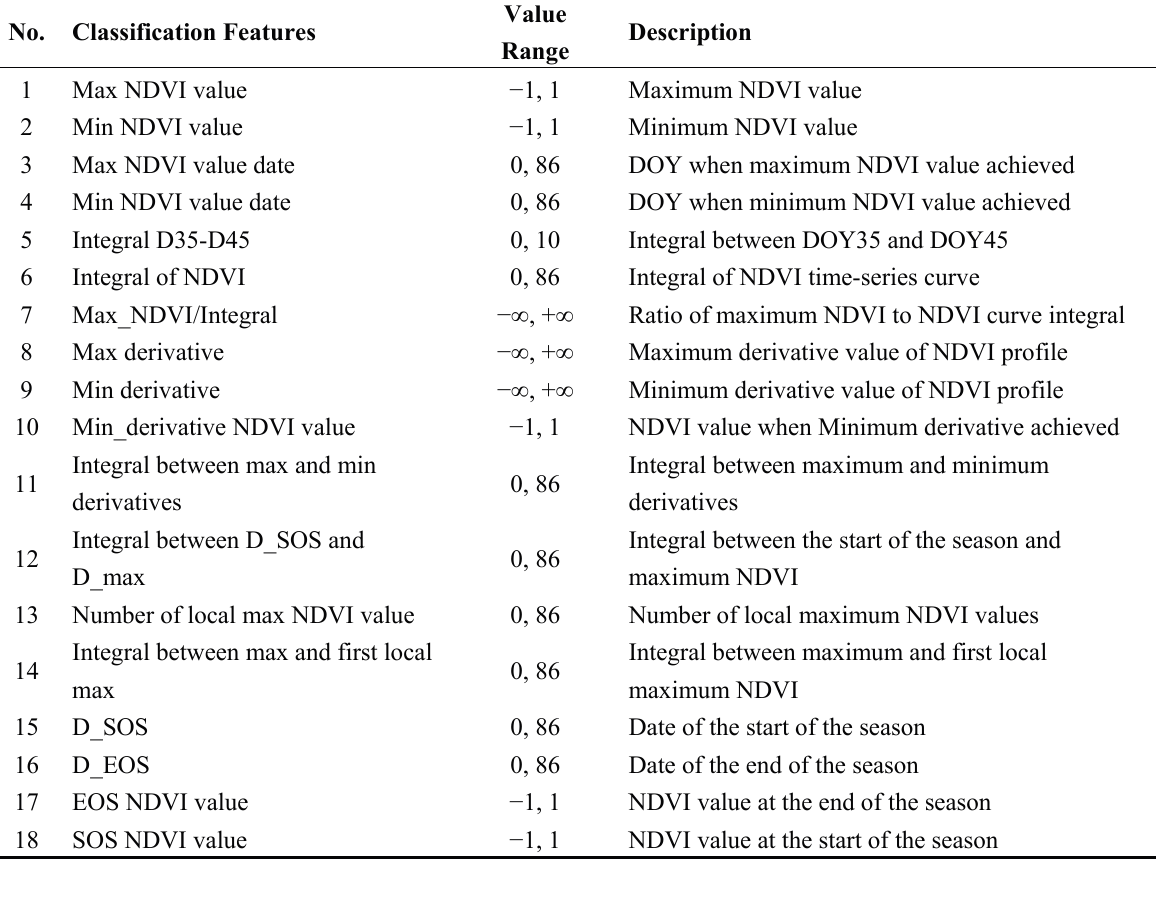
Table 2. The 18 features that were extracted for the classification of the C3 and C4 vegetation.